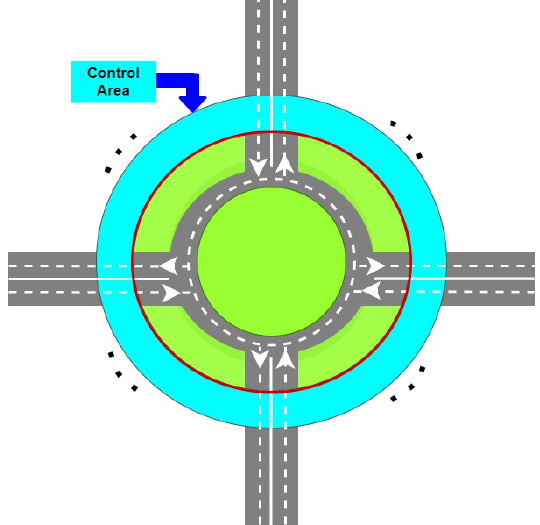
Figure 2. Roundabout intersection ( n